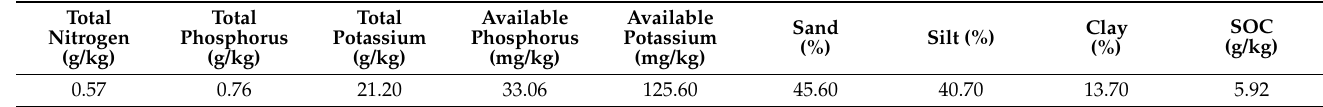
Table 1. Physical and chemical properties of soil in field under